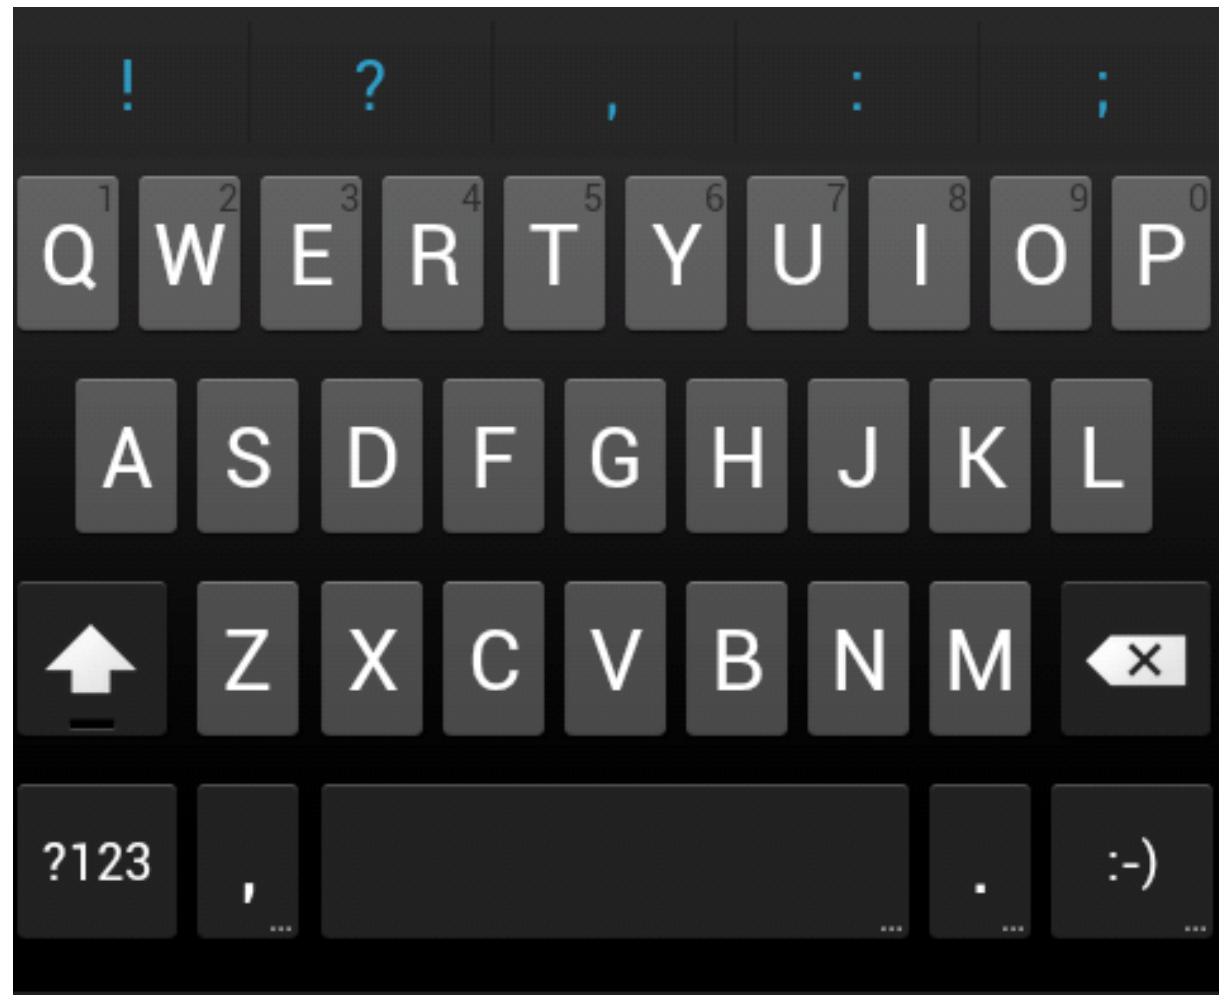
Figure 3. Android ICS keyboard layout.